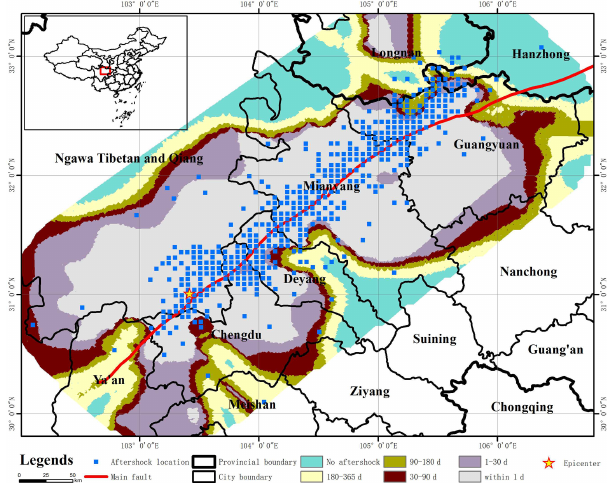
Figure 7. Aftershock hysteresis effect of the Wenchuan earthquake. The aftershock hysteresis effect can be observed by combining the aftershock patterns of the Wenchuan earthquake at different timescales. The blue dots indicate the locations of the actual after- shocks over 1